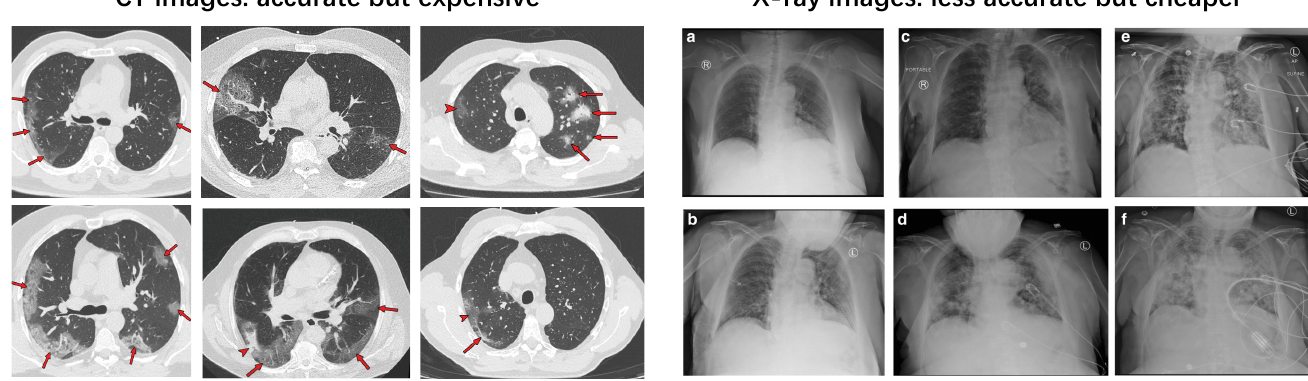
Figure 2. Typical CT ( left ) [30] and chest X-ray ( right ) [32] images of COVID-19-infected patients. The right subfigure a–f represents different cases, please refer to [32] for more